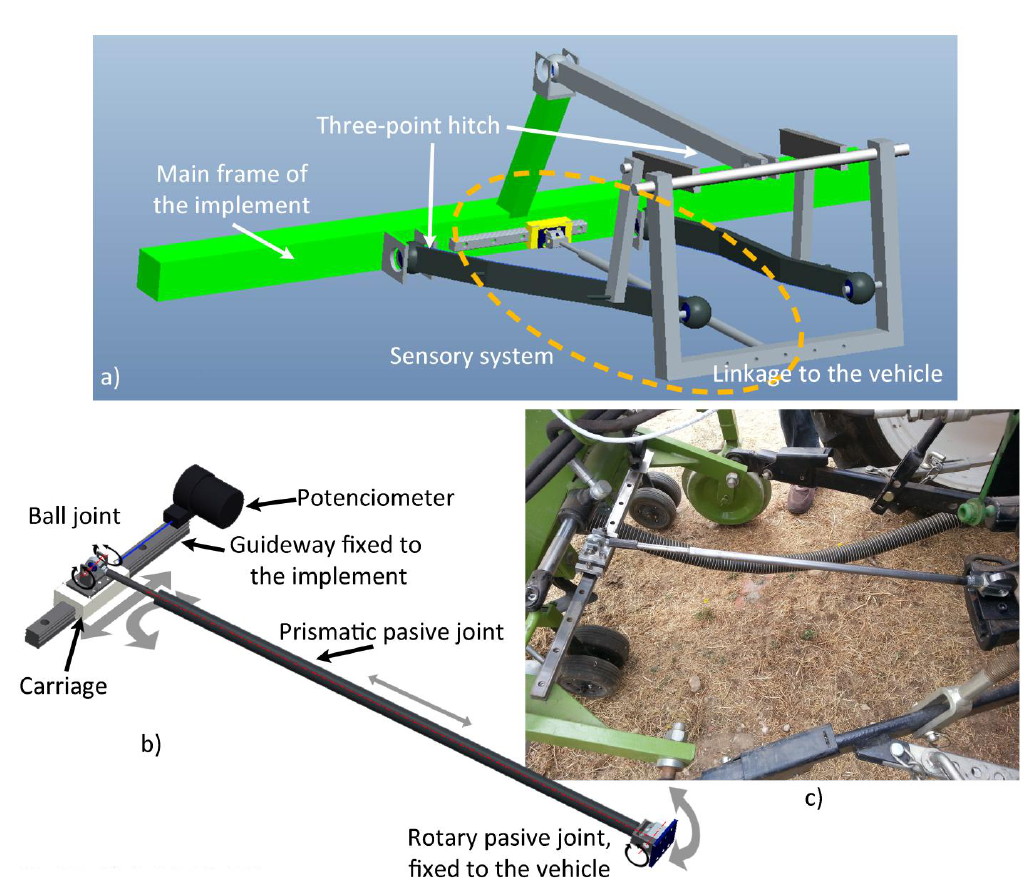
Figure 8. Lateral-position sensor setup. ( a ) Assembly diagram of the sensory system between the implement and the vehicle; ( b ) Structure of the sensory system; ( c ) Photo of actual sensory